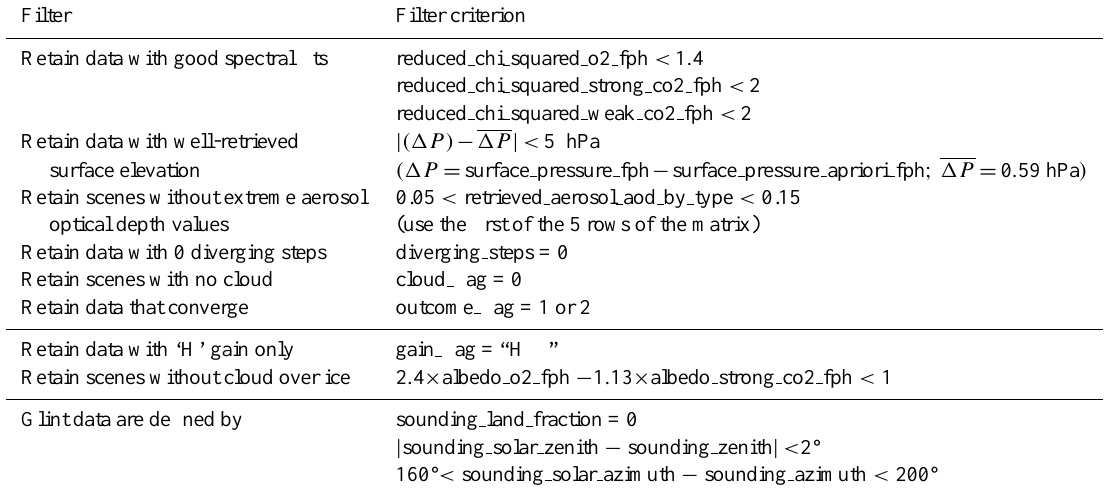
Table B1. Filters applied to the ACOS v2.9 data. Filter